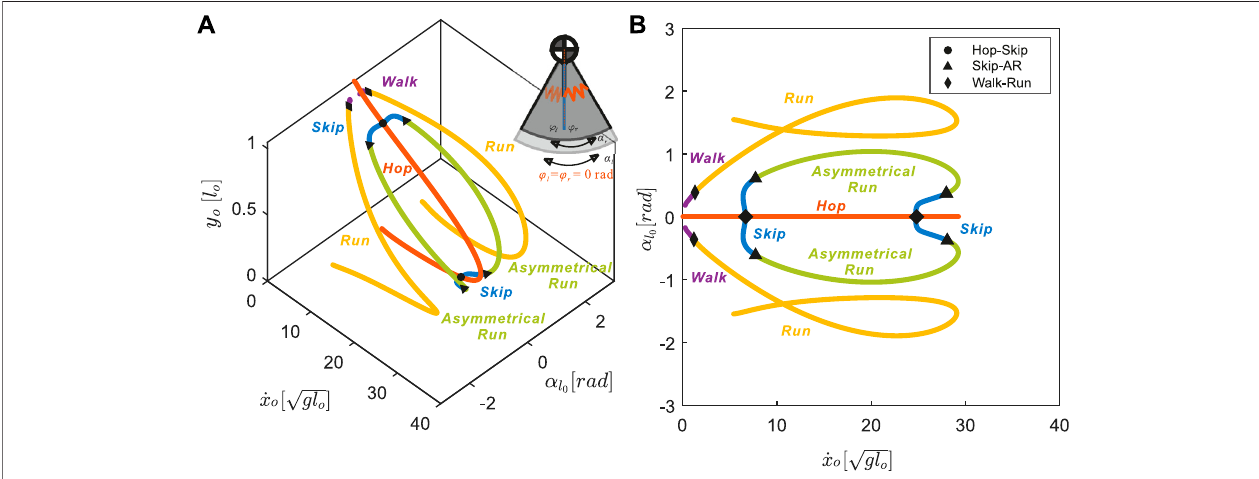
FIGURE 4 | The nominal model with neutral swing leg angles of zero, φ l = φ r =0[ rad ], results in symmetrical gait structures (all other parameters were fi xed as described in Section 3.1). Each point on the branches represents a distinct periodic motion, or a stationary point on (A) a 3D projection and (B) a 2D projection of the Poincarésection ( _ y (cid:2) 0 ) with respect to the apex height y o , forwardspeed _ x o , and left leg angle α l tosymmetricalrunningtransitionarerepresentedbycircles,triangles,anddiamondsrespectively.Forgaitsolutionswithanegativelegangle,theoppositeleghasa phase